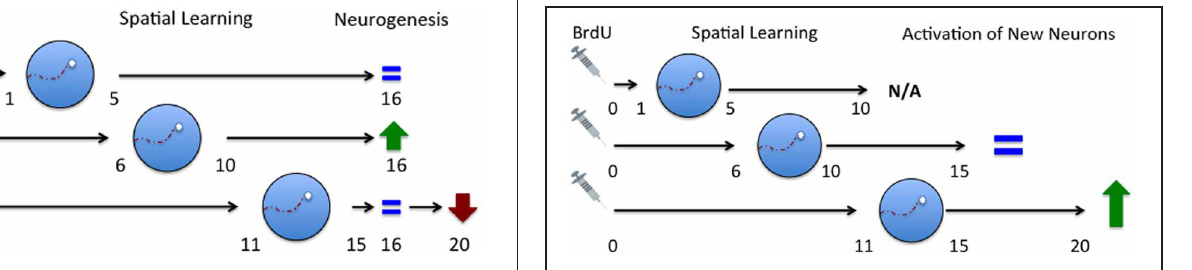
FIGURE 3 | Time course of activation of immature neurons in response to spatial memory. Spatial learning occurred either 1–5, 6–10, or 11–15 days following BrdU administration. The rats were then tested with a probe trial 5 days later and were then perfused 2h later. No activation was seen in 10-day-old neurons. Rats trained on the spatial version of the task on days 6–10 had a small percentage of 15 day old neurons were activated but no difference existed between rats that received spatial versus non-spatial training (Epp et al., 2011a). Rats trained the spatial version of the task on days 6–10 (Chow et al., in press) or 11–15 showed enhanced activation of 20 day old neurons compared to rats that were trained on the non-spatial version of the task (Epp et al., 2011a). N/A, no activation; IEG, immediate early gene. Described changes in activation are in comparison to rats trained on a cued version of the